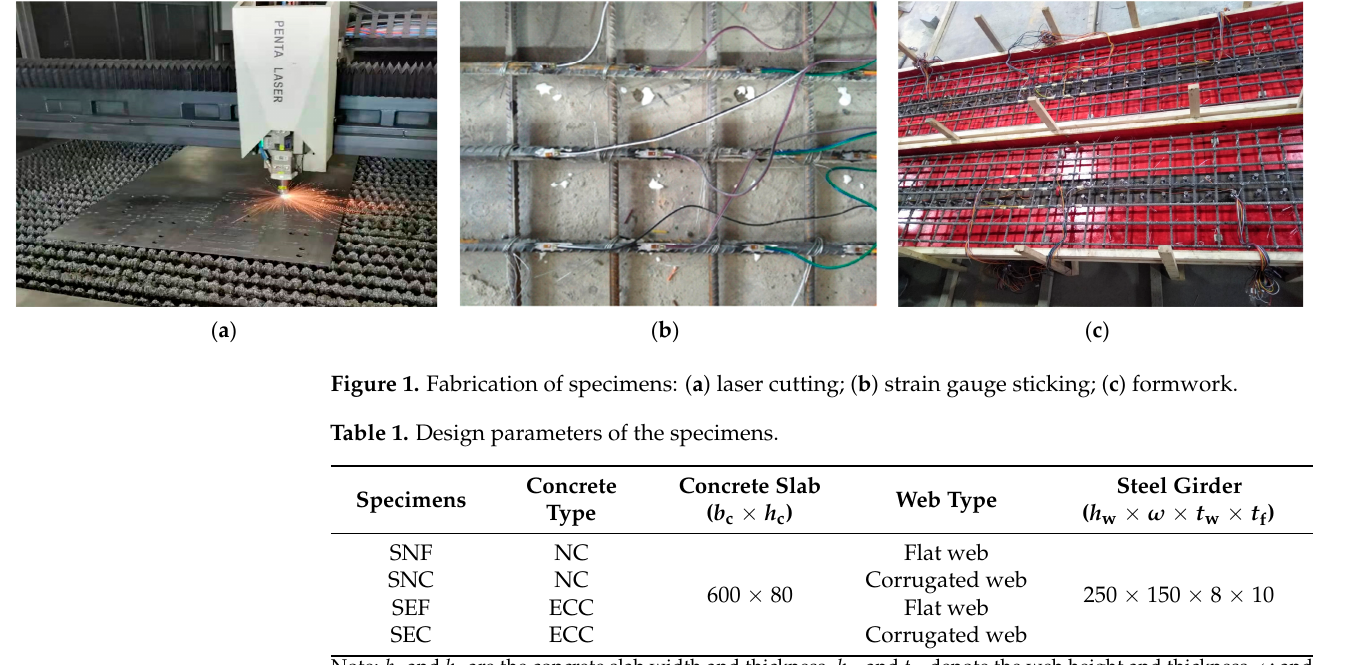
Table 1. Design parameters of the specimens.